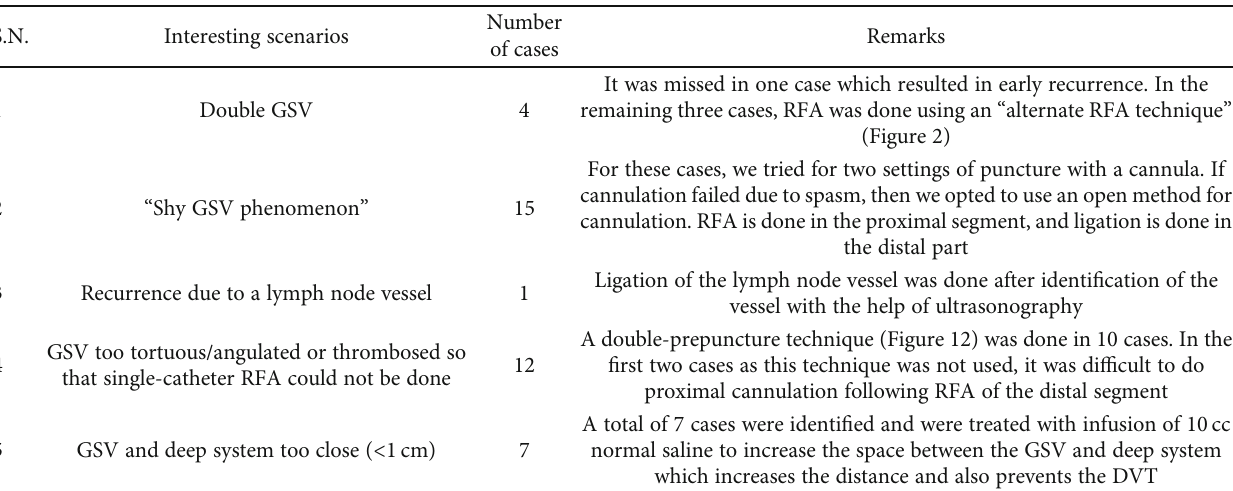
Table 2: Interesting scenarios during RFA of varicose